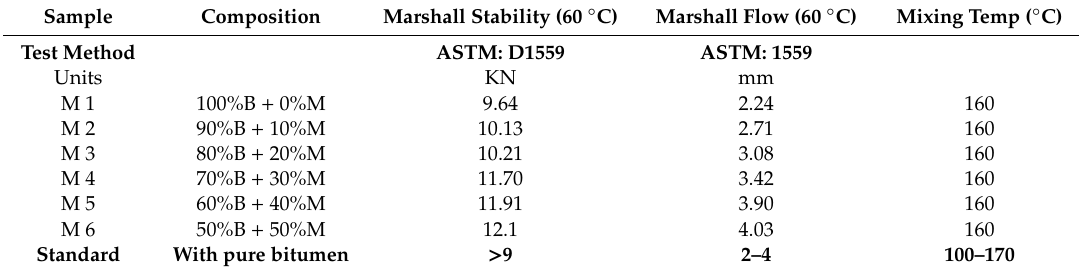
Table 4. Stability and flow analysis of asphalt mix samples with modified and unmodified bitumen.